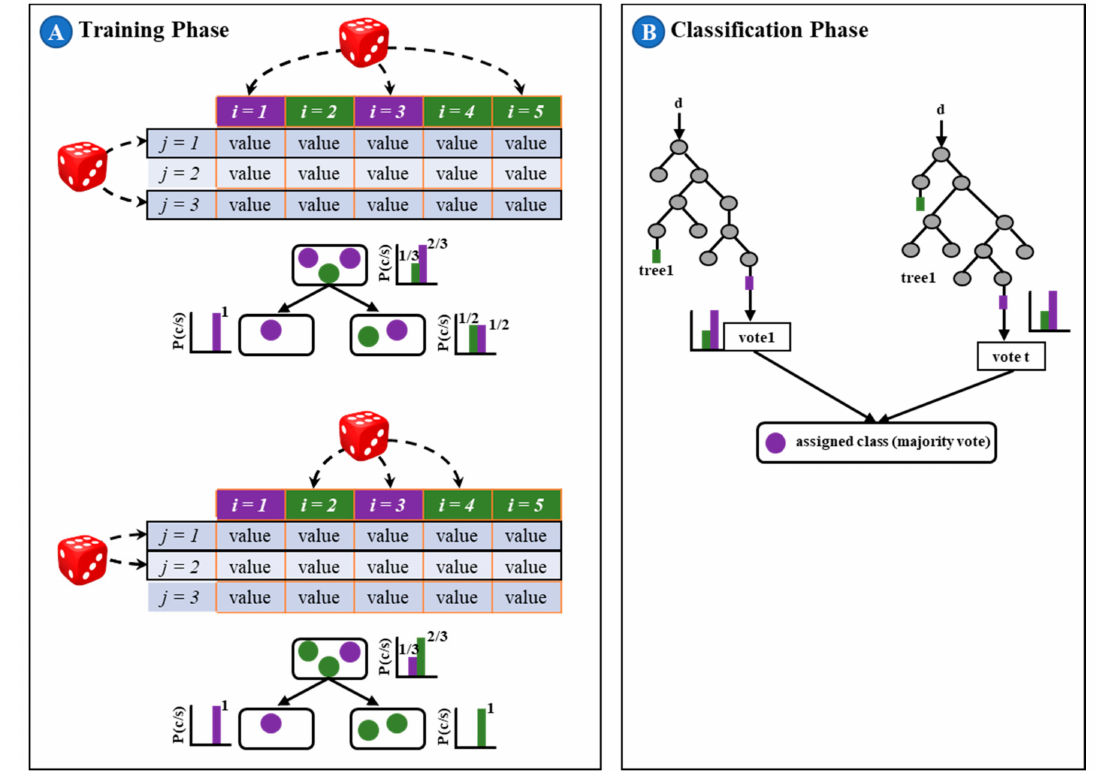
Figure 11. Random forest classifier schematic: i = samples, j = variables, p = probability, c = class, s = data, t = number of trees, d = new data to be classified, and value = the different values that the variable j can have, adapted from